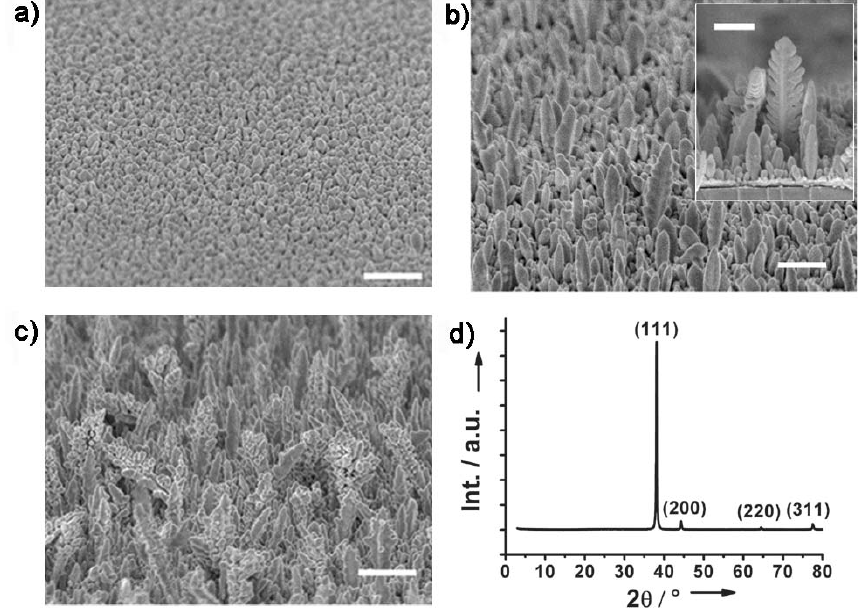
Figure 2. SEM images of nanostructured Au electrodes by electrochemical deposition at - 0.2 V for a) 400, b) 800, c) 1200 s; The inset in b) is side view from 90°, and other SEM images are side views from 45°, all scale bars are 500 nm; d) XRD patterns of